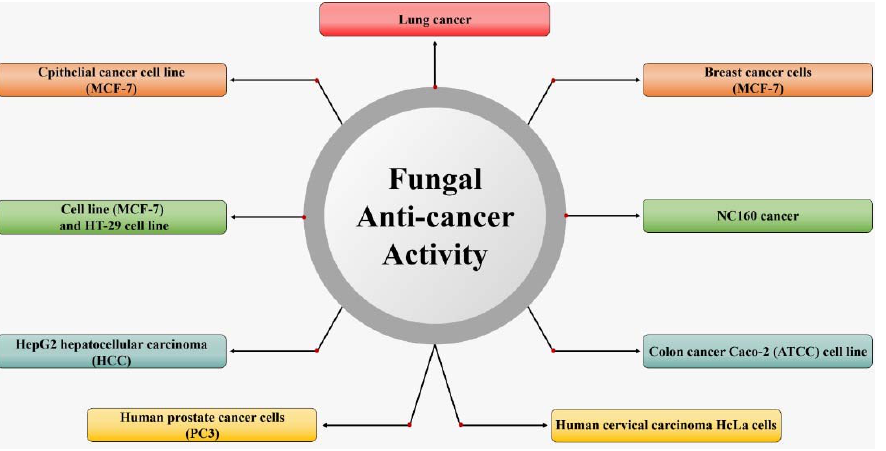
Figure 1. Applications of fungi in the environment to medicine.